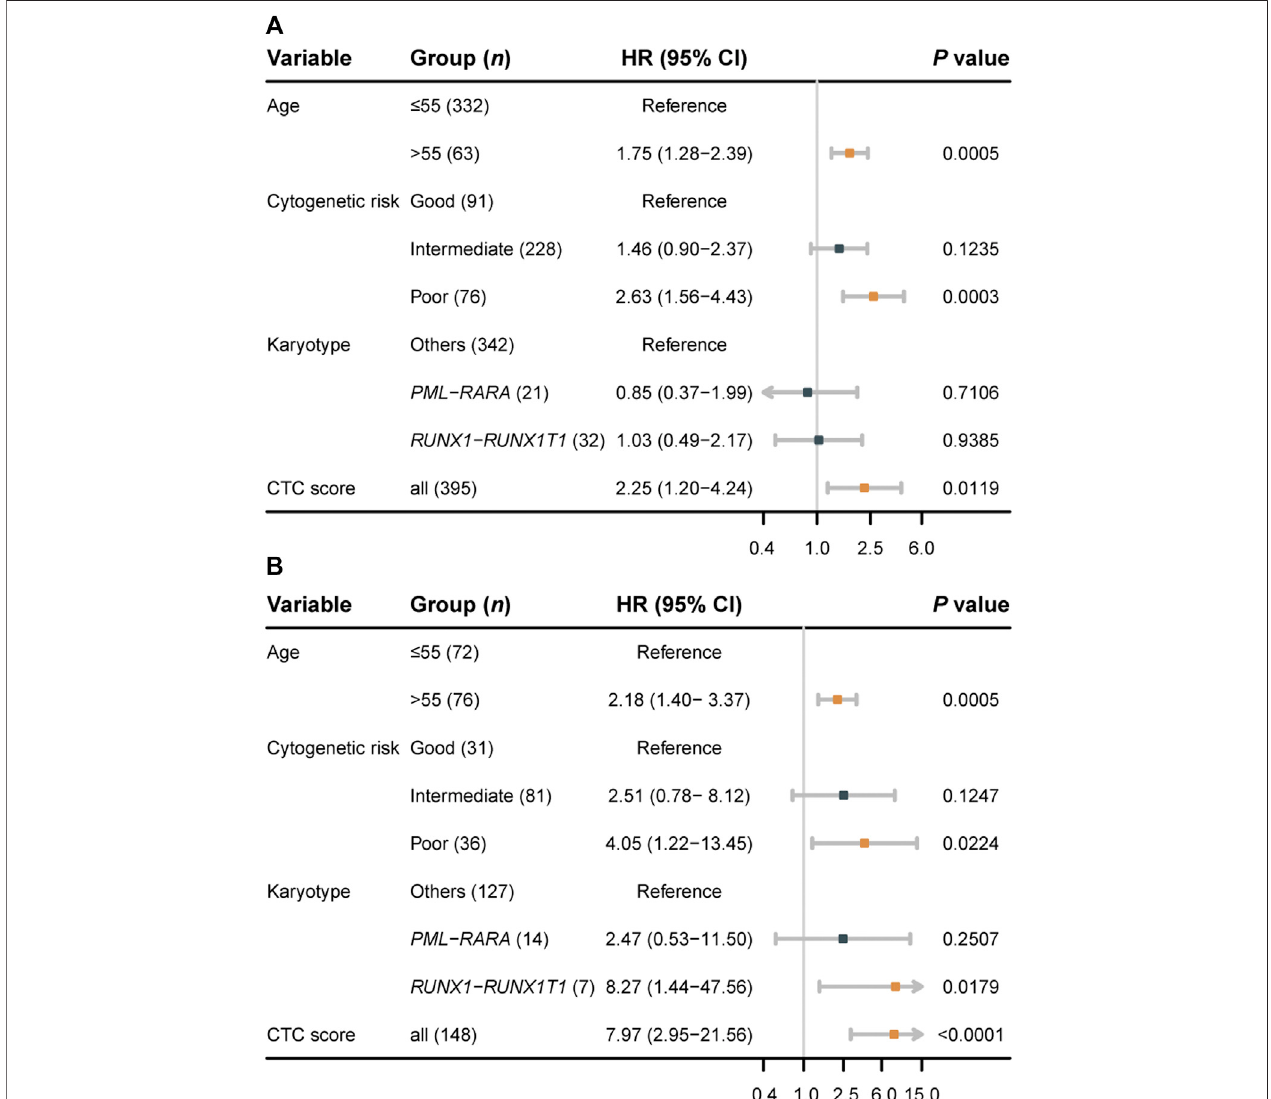
FIGURE 3 | Forest plots of multivariable Cox regression results for the training set GSE6891 (A) and the validation set TCGA-LAML (B) .